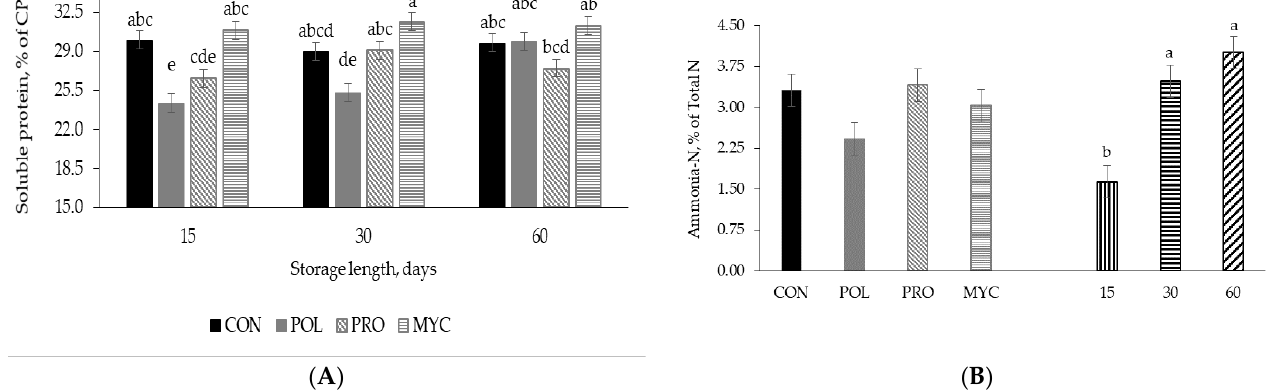
There was an interaction ( p < 0.01) between the additive and storage length for the soluble protein content (Figure 1A). At d-15, POL showed a lower ( p < 0.05) soluble protein content than CON and MYC, and after d-30 it also revealed a lower ( p < 0.05) soluble protein content than MYC. After 60 d of ensiling, no differences were observed among treatments for soluble protein. Ammonia-N increased ( p < 0.05) from d-15 of storage through the storage length studied (Figure 1B).